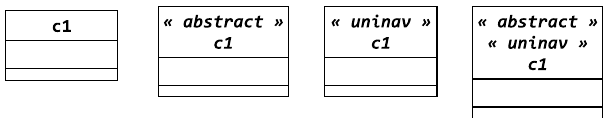
Fig. 6. Graphical representation of the collection ( Coll )